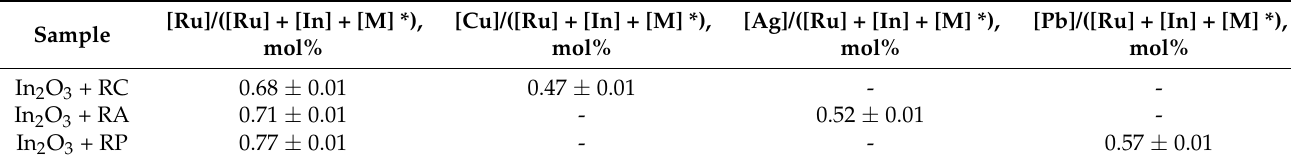
Table 1. Elemental composition of hybrid materials.